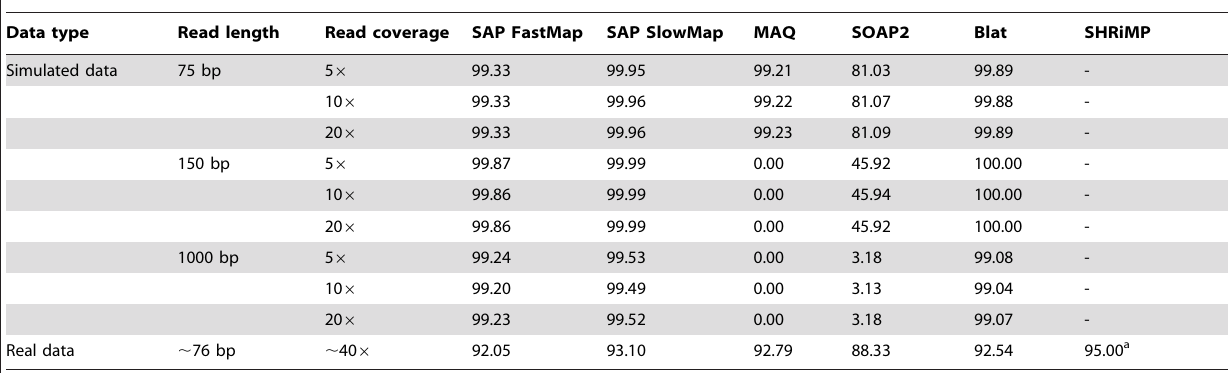
Table 2. Percentage of captured reads by different algorithms.